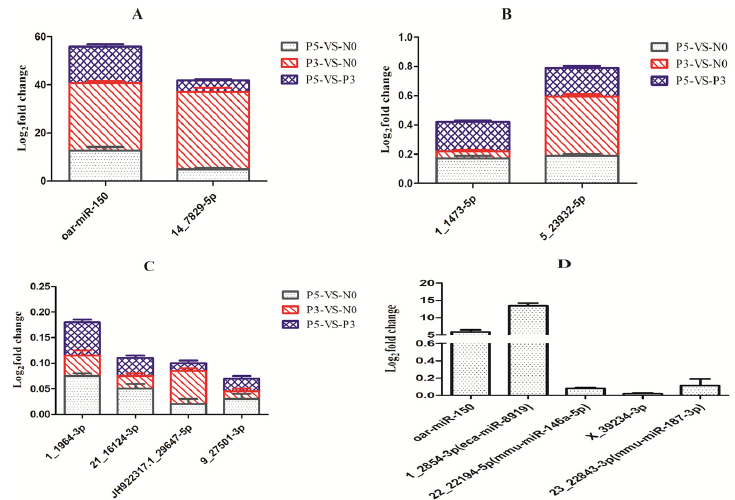
Figure 6. RT-qPCR validate of sequencing data. The change in the miRNA expression of ( A ) oar-miR-150 Figure 6. RT ‐ qPCR validate of sequencing data. The change in the miRNA expression of ( A ) and 14_7829-5p in PBMC, ( B ) 1_1473-5p and 5_23932-5p in PBMC, ( C ) 1_1964-3p, 21_16124-3p, oar ‐ miR ‐ 150 and 14_7829 ‐ 5p in PBMC, ( B ) 1_1473 ‐ 5p and 5_23932 ‐ 5p in PBMC, ( C ) 1_1964 ‐ 3p, JH922317.1_29647-5p and 9_27501-3p in PBMC, and ( D ) oar-miR-150, 1_2854-3p, 22_22194-5p, 21_16124 ‐ 3p, JH922317.1_29647 ‐ 5p and 9_27501 ‐ 3p in PBMC, and ( D ) oar ‐ miR ‐ 150, 1_2854 ‐ 3p, X_39234-3p and 23_22843-3p in ST cells were calculated with SNORA58 as reference gene for 22_22194 ‐ 5p, X_39234 ‐ 3p and 23_22843 ‐ 3p in ST cells were calculated with SNORA58 as reference normalization. Fold change is represented as gene for normalization. Fold change is represented as log2FC.